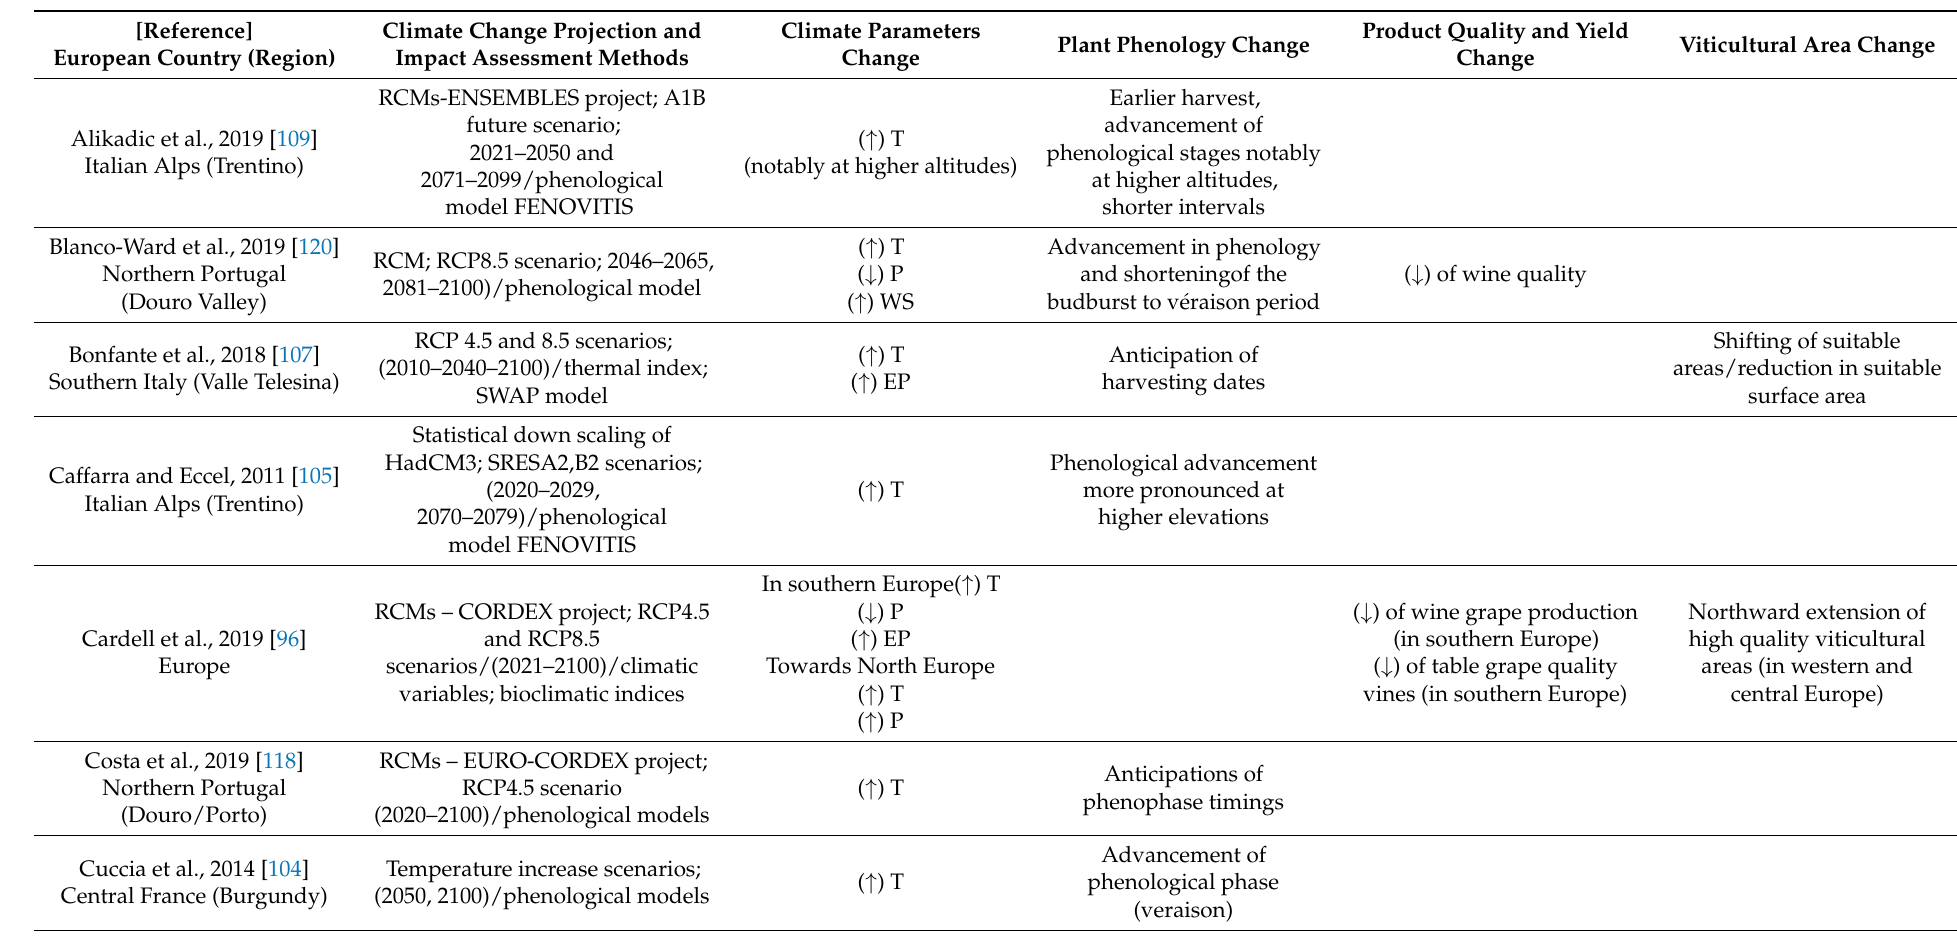
Table A1. Synoptic description of the impacts of climate change on grapevine phenology, product quality, yield and cultivation